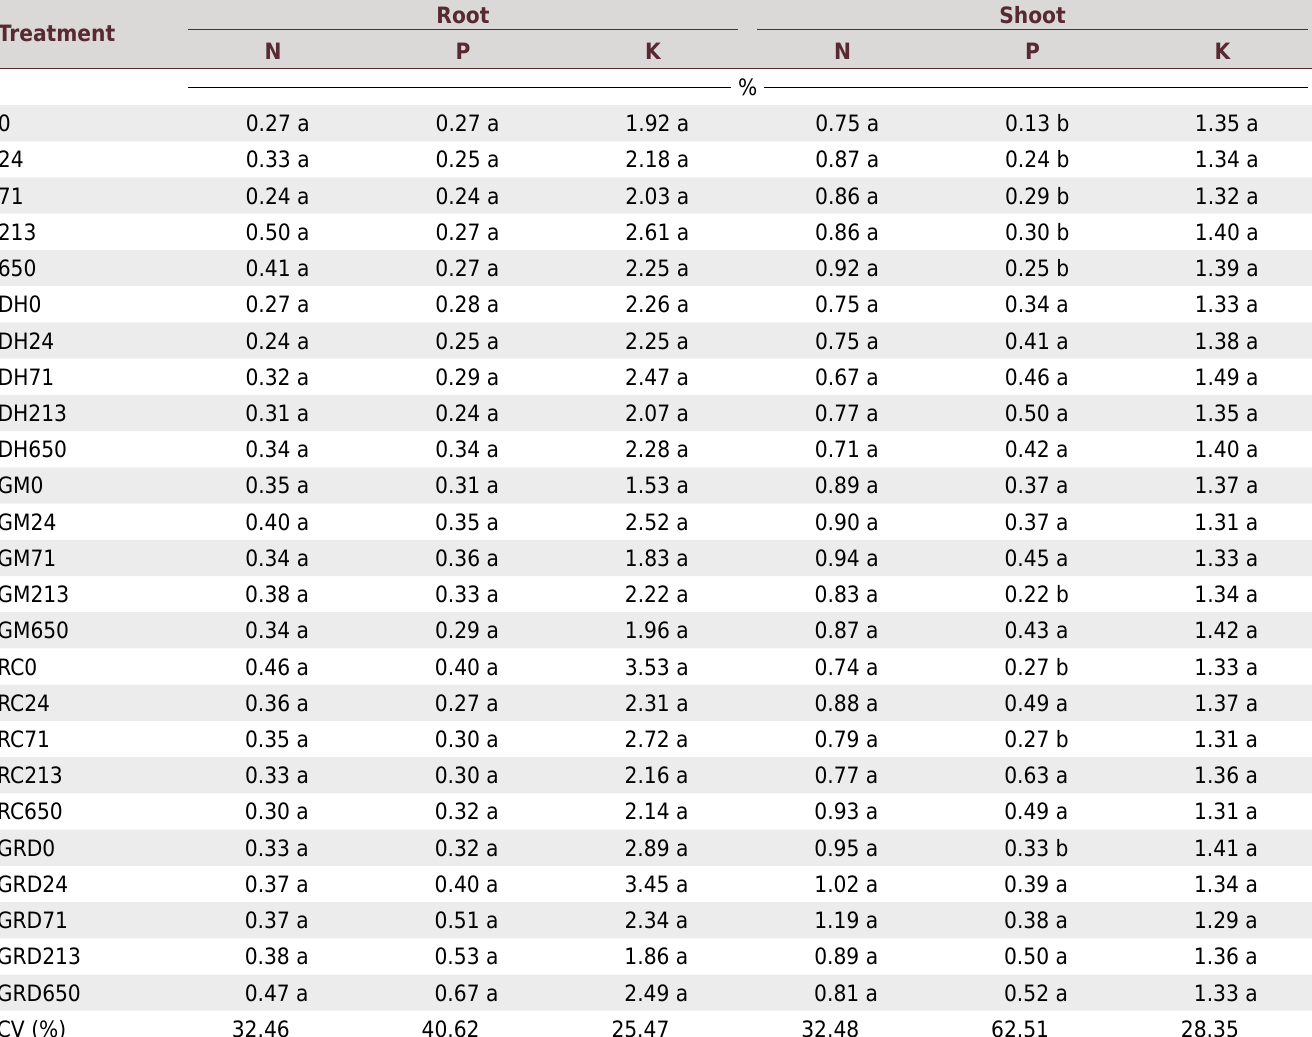
Table 3. Interaction between phosphorus rates and different arbuscular mycorrhizal fungi (AMF) on nutritional characteristics of Apuleia leiocarpa Treatment